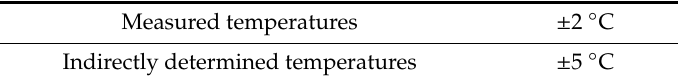
Table 1. Definitions of standard tolerances in Table 4.6 of